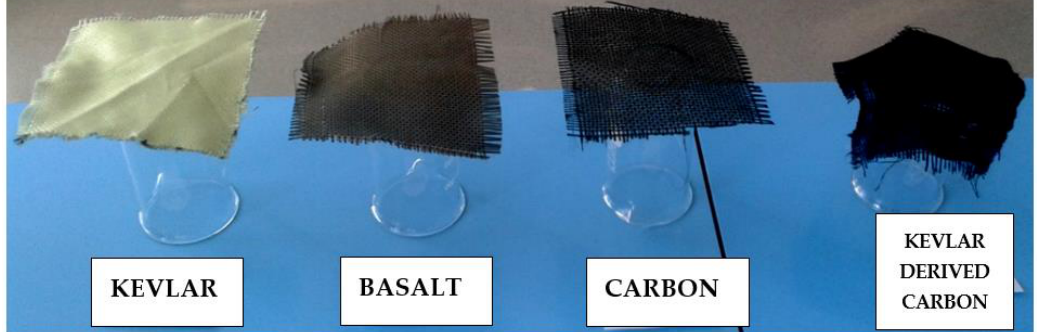
Figure 3. Flexibility of produced activated carbon fabric and other regular fabrics.